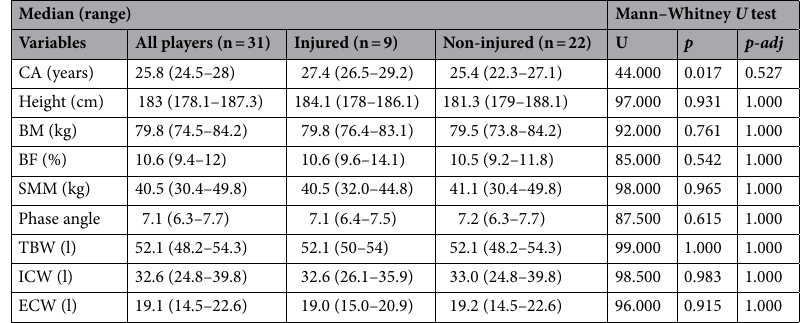
Table 1. Descriptive statistics for chronological age and body composition and results of Mann–Whitney U test. 95% CI 95% confidence interval, CA chronological age, BF % body fat percentage, TBW total body water,